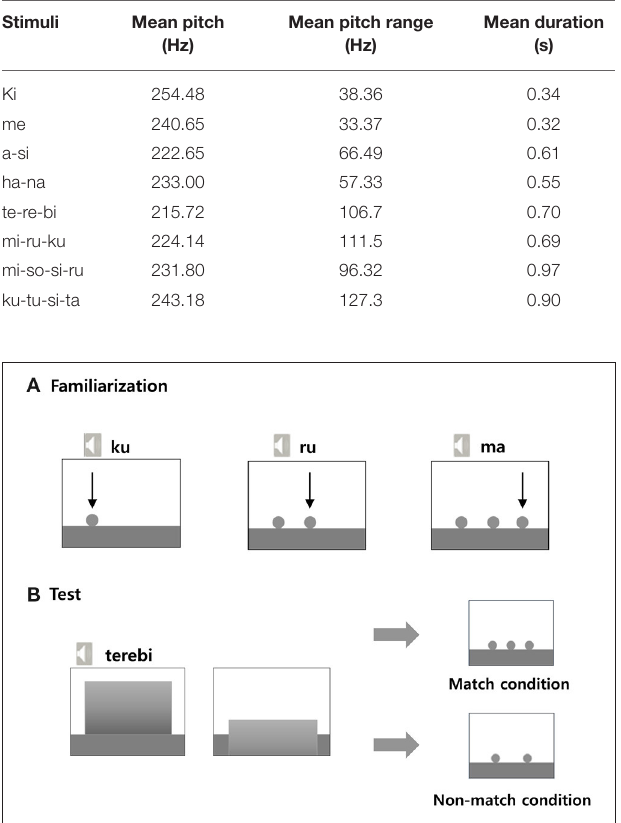
FIGURE 1 | Presentation sequences in the three-syllable condition during the familiarization trial (A) and test trial (B) .